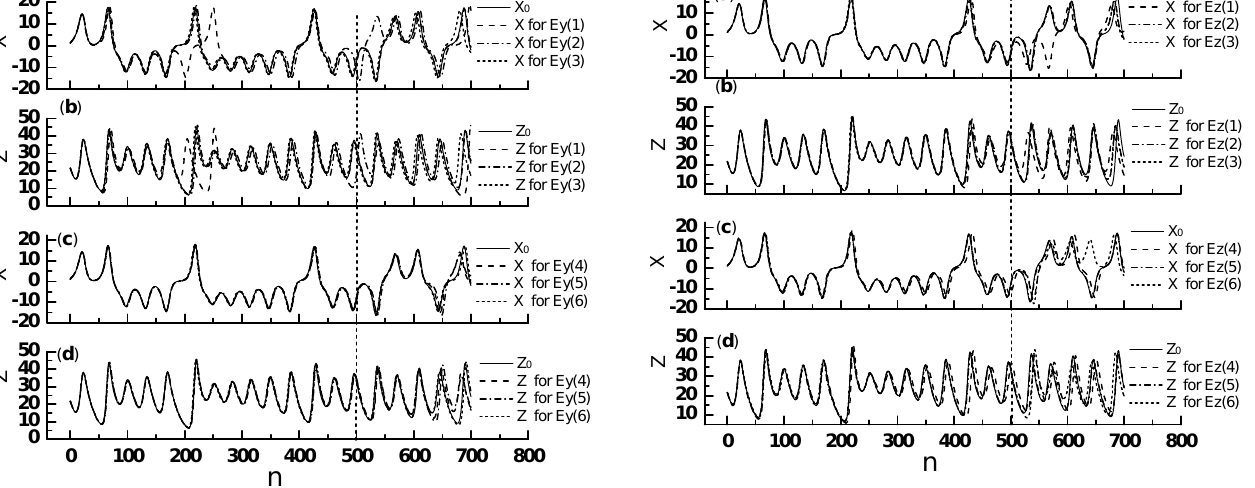
Fig. 4. Error correction based on the second component L y (x,y,z) using EM. (a) and (b) are the fitting and prediction data of the corrected models using the error function E ( 1 ) y ,E ( 2 ) y ,E ( 3 ) y , respectively. (c) and (d) are the same as (a) and (b) , but for E ( 4 ) y ,E ( 5 ) y ,E ( 6 ) y , respectively.